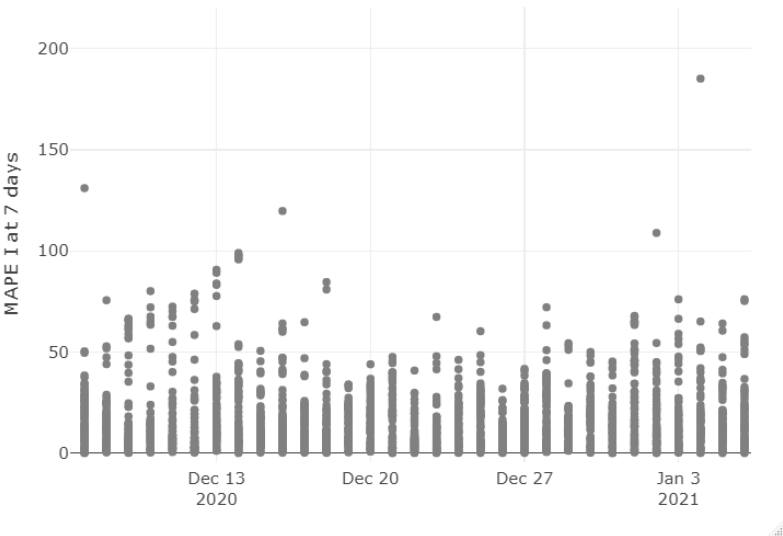
Figure 7. MAPE on weekly predictions over time. The dates on the horizontal axis represent the time window limit on which the training was done. The vertical axis displays the absolute error between real and predicted on the seventh day after that date for each